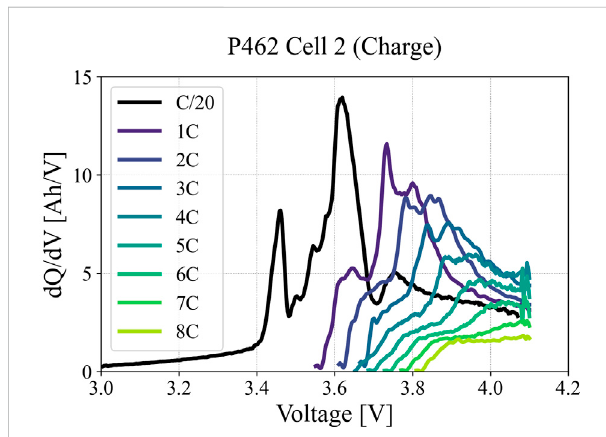
FIGURE 7 Effect of charging C-rates on dQ/dV pro fi les for NMC532/Gr pouch cells with moderate energy storage loading. In practical terms the data becomes unusable above the 2C rate.